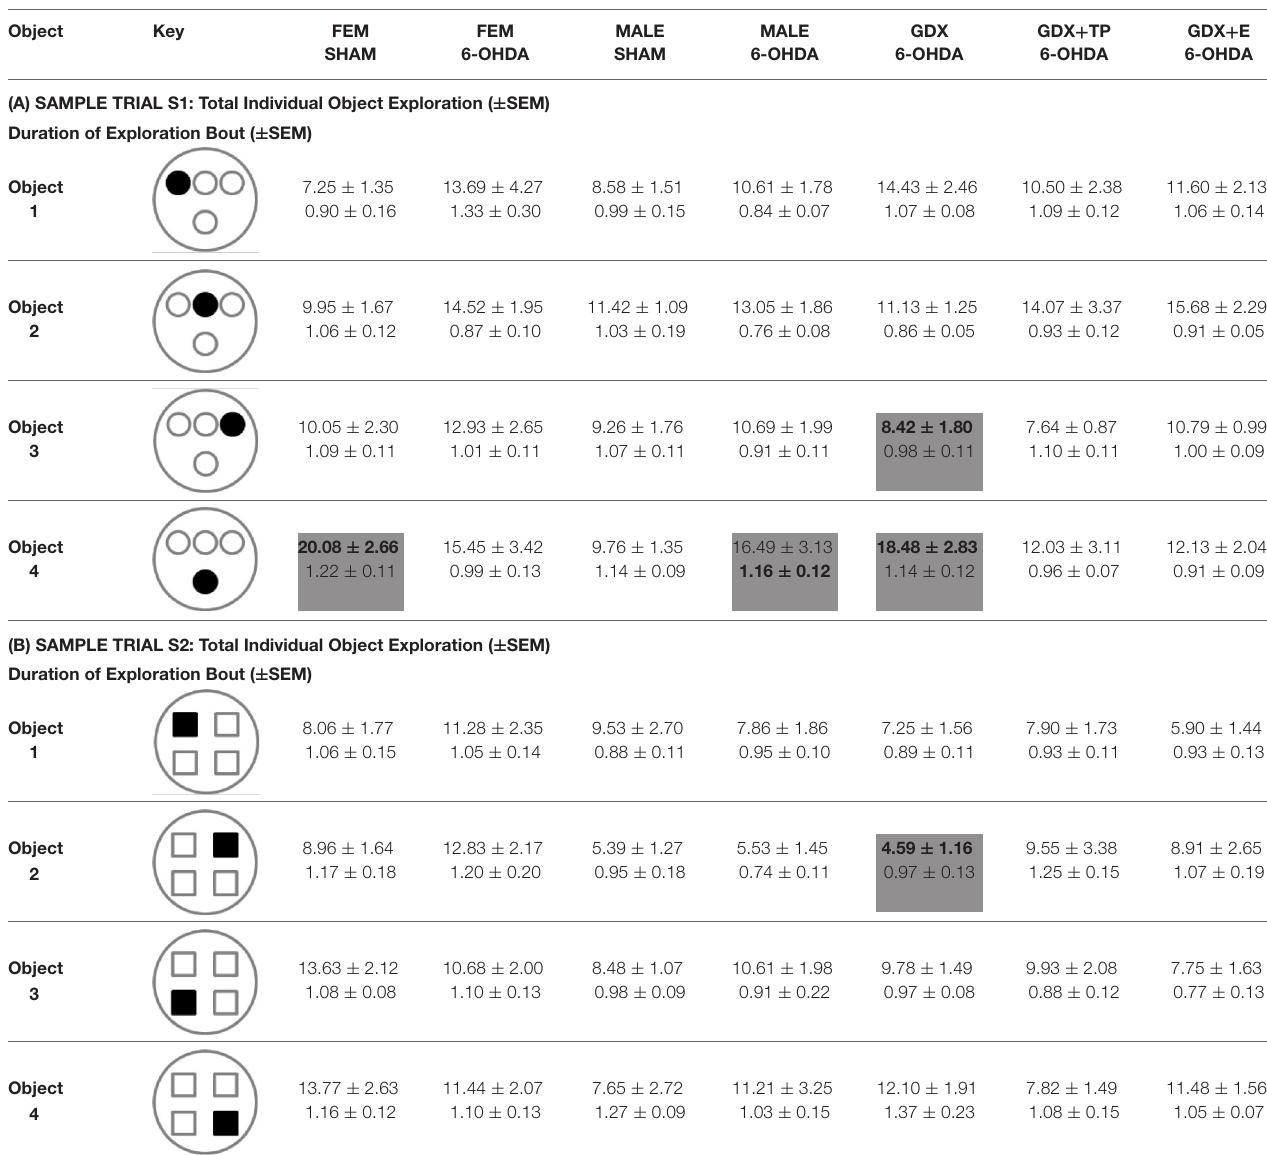
FEM MALE MALE GDX GDX + TP SHAM 6-OHDA SHAM 6-OHDA 6-OHDA 6-OHDA